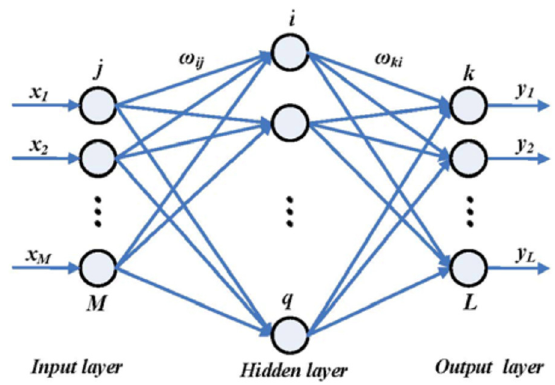
Figure 18. The architecture of a three-layer BP neural network